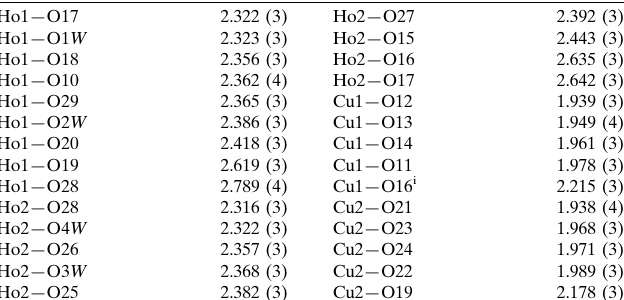
Selected bond lengths (A˚